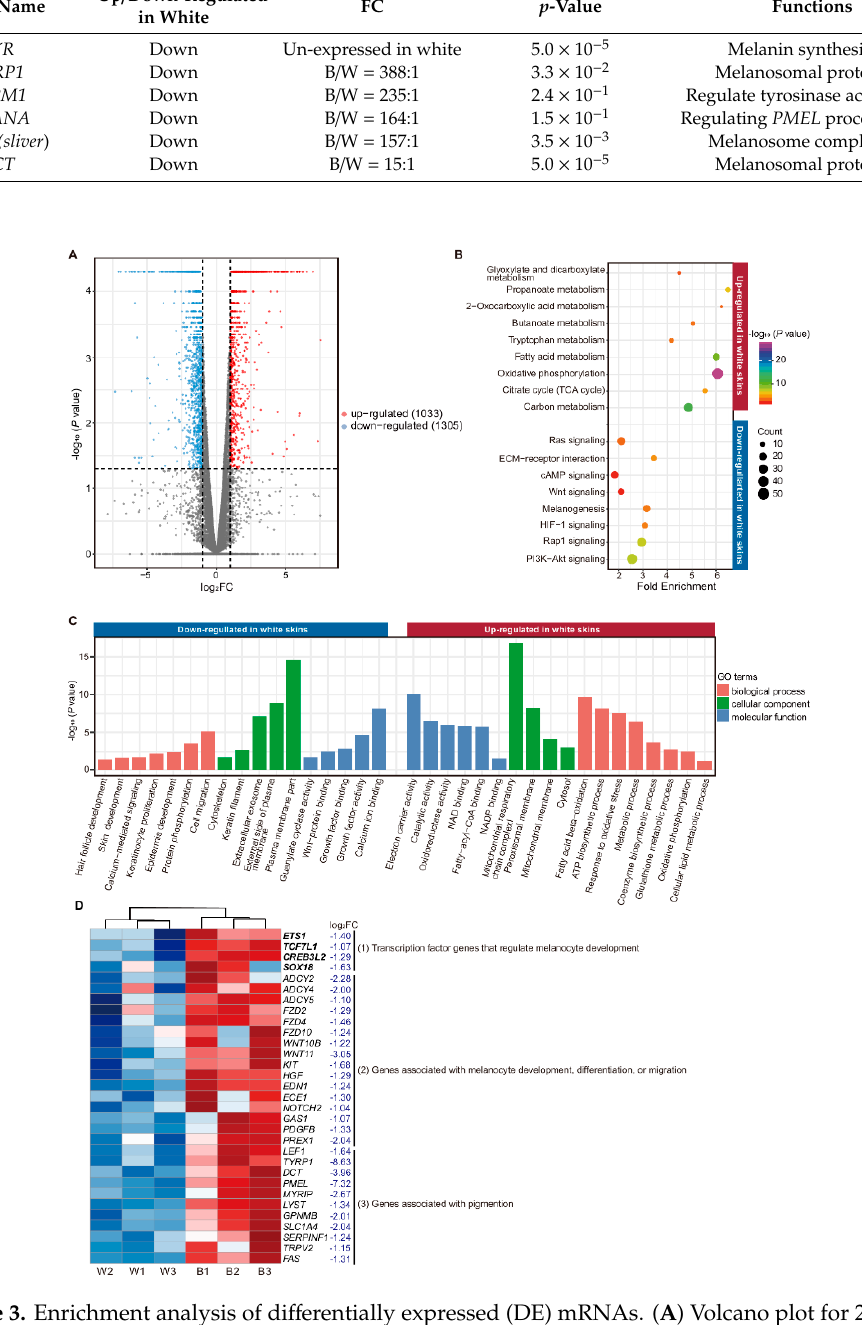
Figure 3. Enrichment analysis of differentially expressed (DE) mRNAs. ( A ) Volcano plot for 2338 DE genes, of which 1305 were down-regulated in white skins, while 1033 were up-regulated. ( B ) Functional enrichment analysis of the KEGG pathway (genes down-regulated in white skin were marked blue and up-regulated marked red; Benjamini corrected p -value < 0.05). ( C ) Gene ontology (GO) enrichment analysis (genes down-regulated in white skin marked blue and up-regulated marked red p -value < 0.05). ( D ) Identification of genes associated with melanogenesis. The genes in bold are transcript factor genes (cluster (1)).